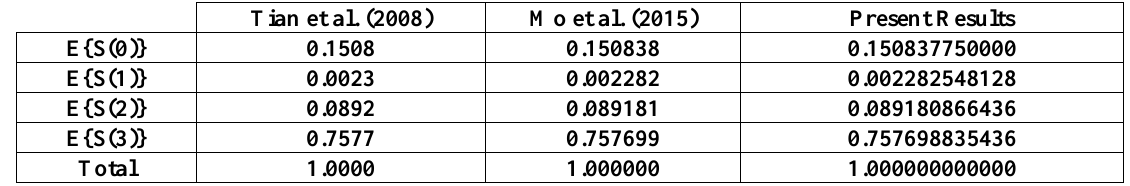
Table 1. Comparison of the present results with those in earlier work Tian et al. (2008) Mo et al. (2015) Present